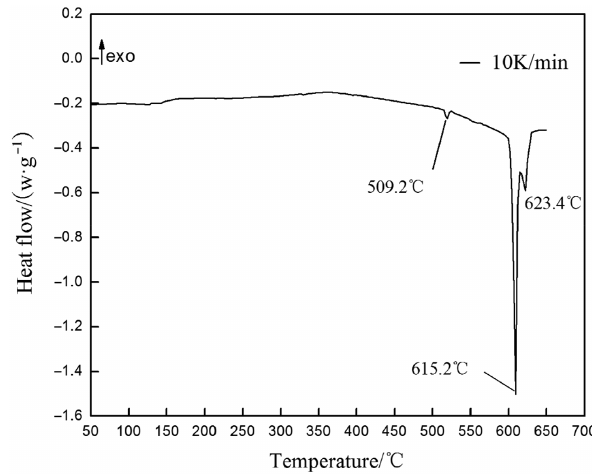
Figure 1: DSC curve for heating process. Copper-rich phase start to melt at